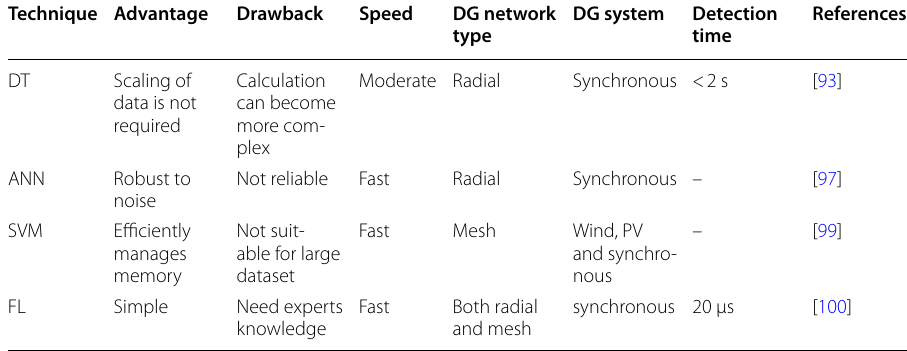
Table 6 Summary of various intelligence-based island detection technique Technique Advantage